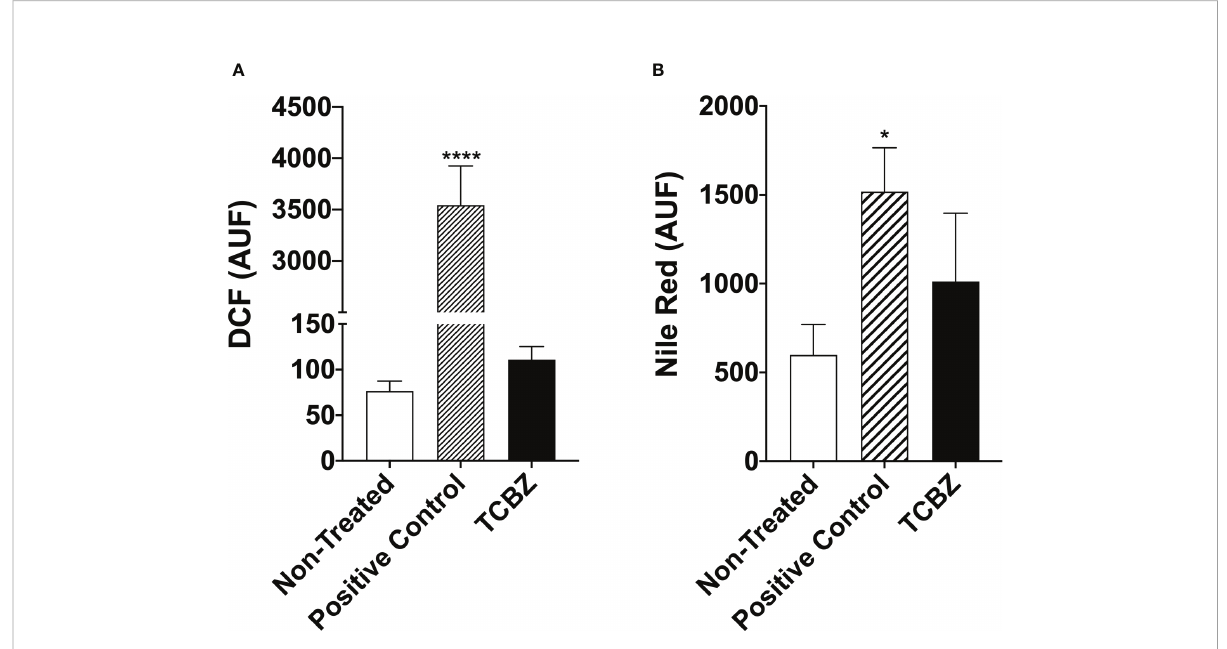
FIGURE 9 Reactive oxygen species evaluation and lipid quanti fi cation in L. amazonensis promastigotes treated with TCBZ. (A) ROS of L. amazonensis